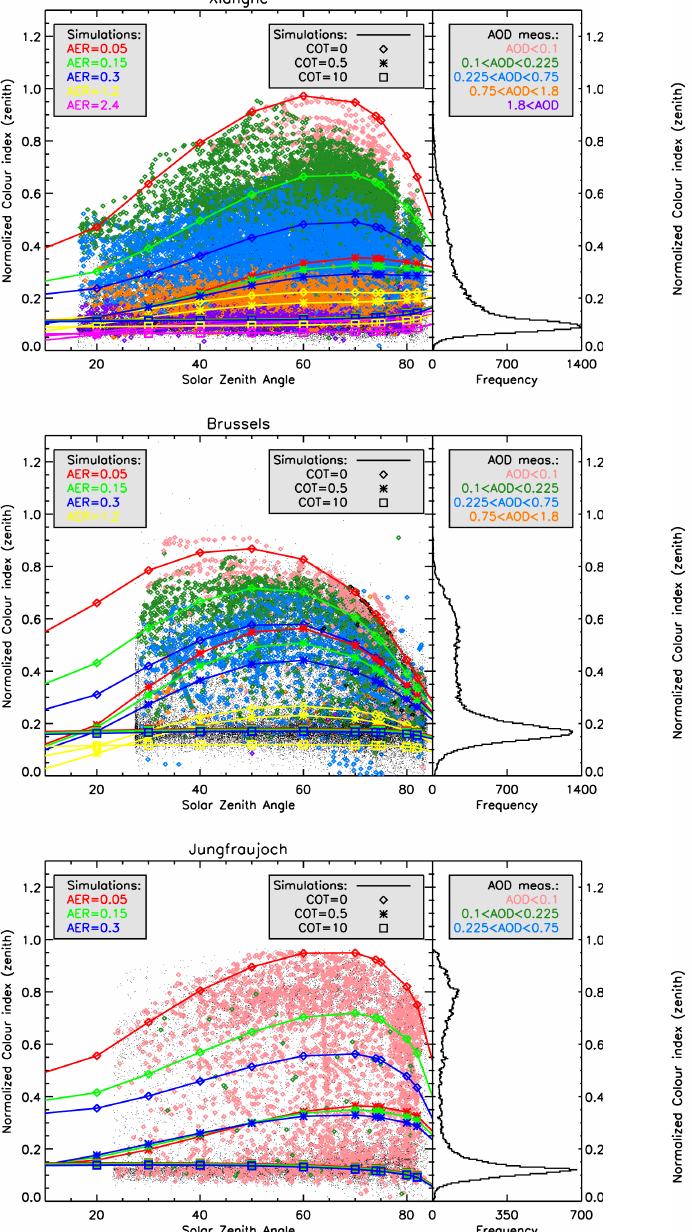
Figure 6. The normalized CI values (points) versus solar zenith an- gle, together with the scaled CI simulations (coloured lines) made under different aerosol and cloud optical depth values (left/middle legend). We colour-marked the observed CI values with additional AOD data if available (right legend).